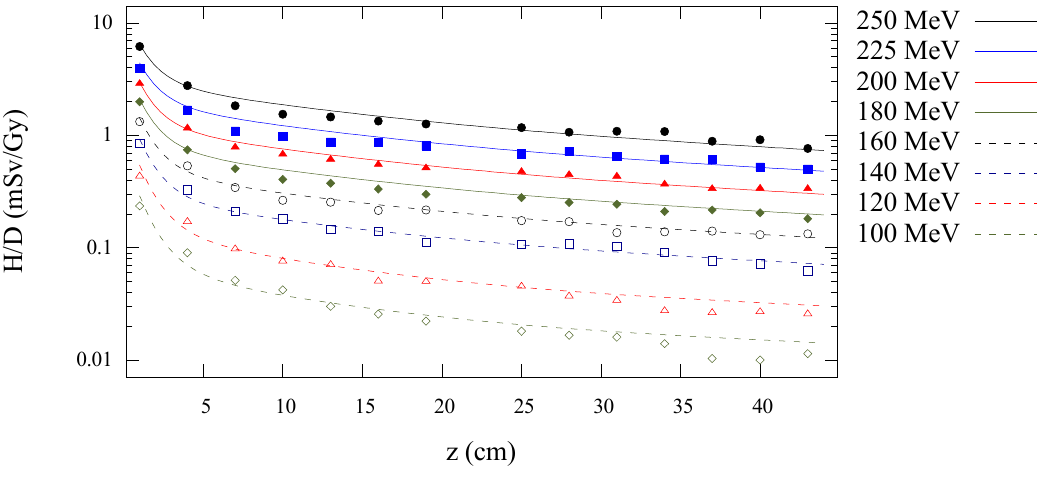
Figure 6. Predictions from Monte Carlo (points) and analytical model (lines) of neutron equivalent dose per treatment dose (𝐻/𝐷) versus depth in water at 40 cm off-axis for 100 to 250 MeV proton beam